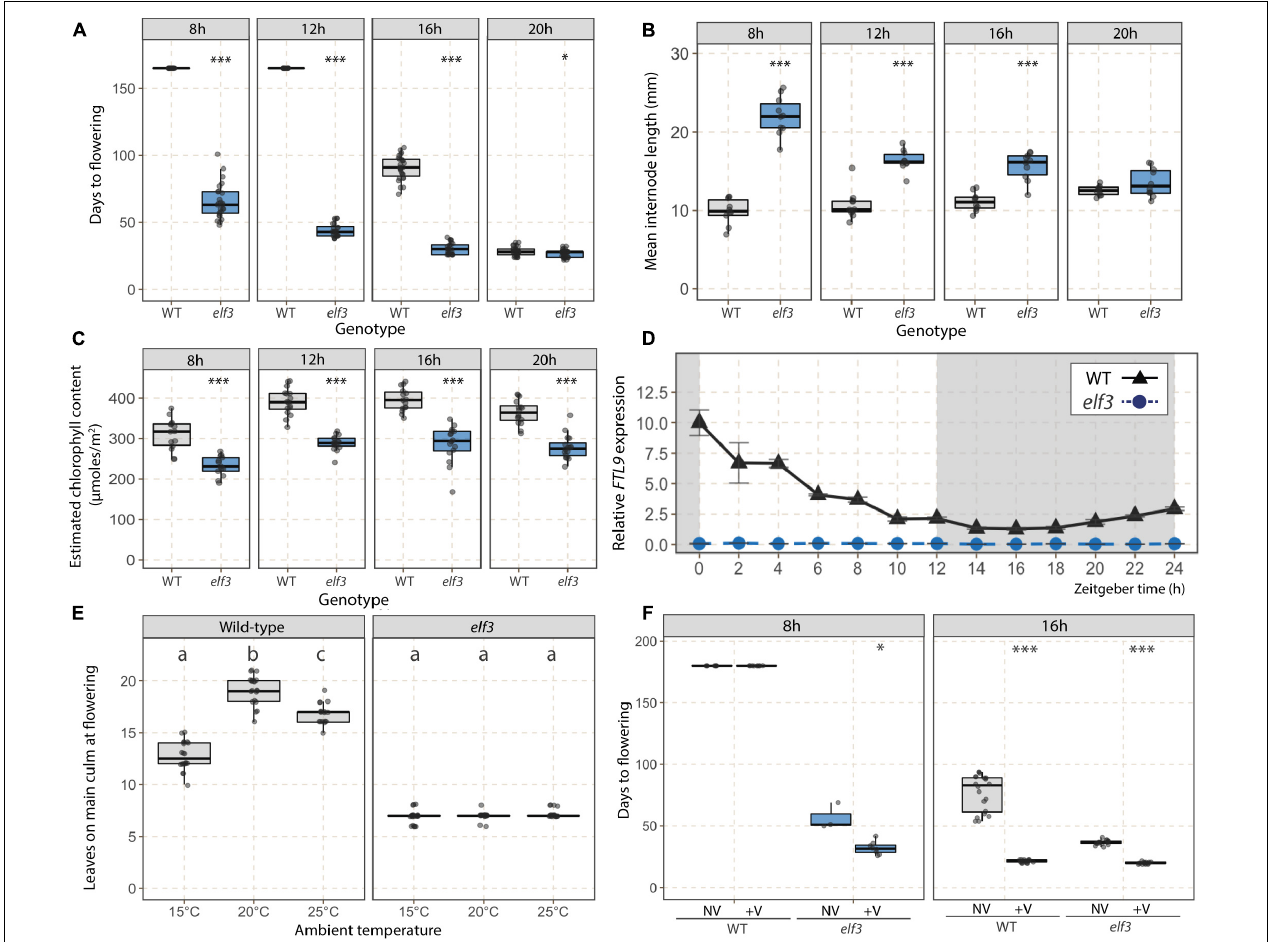
FIGURE 2 | Phenotypic characterization of the elf3 mutant. Flowering time ( A ; days to flowering), mean internode lengths (B) , and estimated chlorophyll contents ( C ; µ moles.m − 2 ) for the elf3 mutant wild-type (WT) plants under 8, 12, 16, and 20 h photoperiods ( n = 10–25). For (B,C) , data were collected 1 week prior to estimated floral transition according to a preliminary experiment. (D) Relative FTL9 expression kinetics in WT (black triangles) and elf3 (blue circles) plants under a 12 h photoperiod. Data were normalized using the geometric mean of ACT3 and UBC18 reference genes. Error bars represent the standard error of the mean. Time is expressed as the number of hours following the start of the light period (Zeitgeber time, ZT). (E) Flowering time (number of leaves on the main culm at flowering) of elf3 mutant and WT plants grown at distinct temperatures. Letters (a,b,c) indicate statistical differences ( p < 0.05) according to a Tukey’s HSD test used to perform multiple comparisons. (F) Flowering time (days to flowering) of elf3 mutant and WT plants exposed (V) or not (NV) to a 3-week vernalizing treatment and subsequently grown under 8 or 16 h photoperiods. Student t -tests were used for pairwise comparisons in (A–C,F) ( ∗∗∗ p < 0.001; ∗ p <